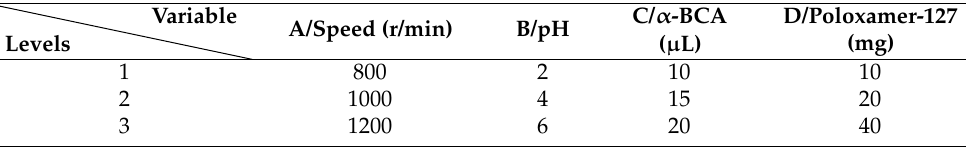
Table 1. Variables and levels in the orthogonal design. Osthol dosage was 5 mg; stirring speed (A), pH value (B), α -BCA (C), and Poloxamer-127 (D) were chosen as the research factors, with 3 levels for each